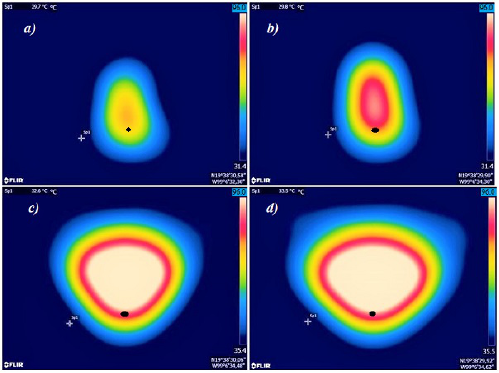
Figure 6. Thermographies that allow the formation and growth of the natural steam chamber in the oil-saturated porous medium contained in the elliptical chamber to be visualized. Each thermography was taken at different time points after the injection start-up: ( a ) t = 9.33 min, ( b ) t = 13.16 min, ( c ) t = 44.50 min, and ( d ) t = 58.66 min. Notice the symmetry of the steam chamber (white region) and that of the isotherms in ( c , d ). The black point indicates the position of the recovery orifice, and it is here that the red isotherm remains nearly invariant in ( a – d ), meaning that the steam-to-water phase change occurs at around T b = 77 ◦